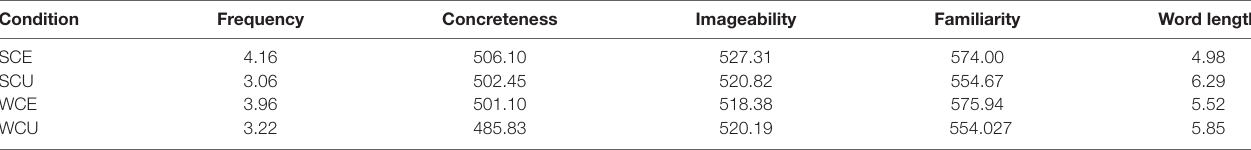
TABLE 1 | Lexical properties of sentence ending words.